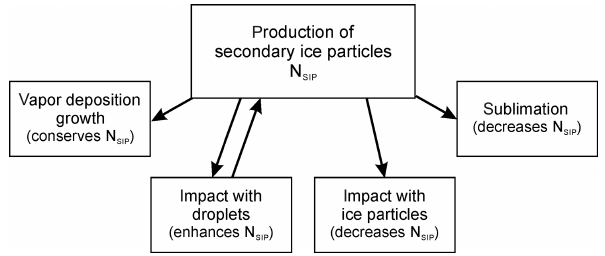
Figure 22. Different scenarios of evolution of SIP particles after their